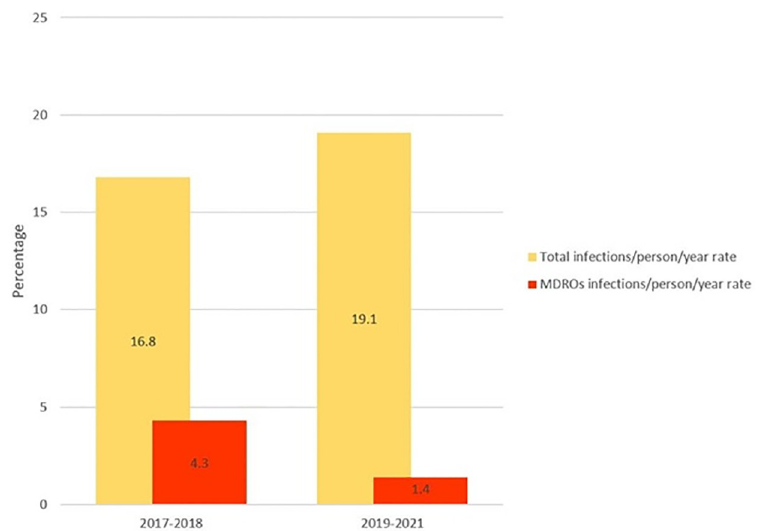
Fig 1. Incidence rates for total infections (MDSOs and MDROs)/person/year and for MDROs infections/person/ year.